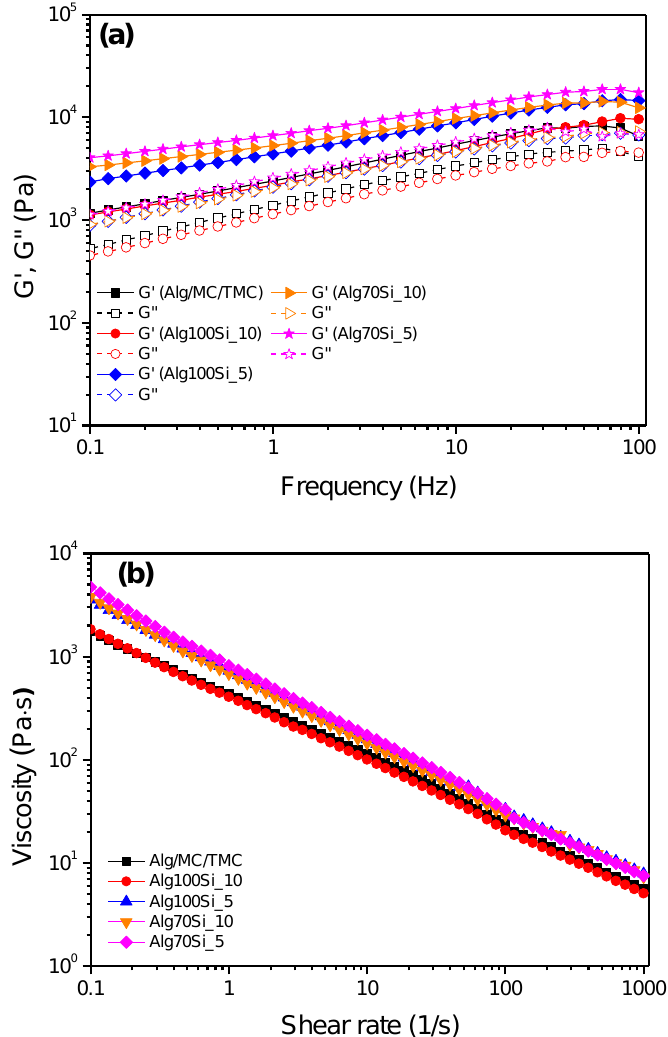
Figure 1. Rheological characterization of the prepared hydrogels: ( a ) mechanical spectra of all sam- ples recorded at 25 °C (0.5% strain), and ( b ) steady-state flow curves of the hydrogels.